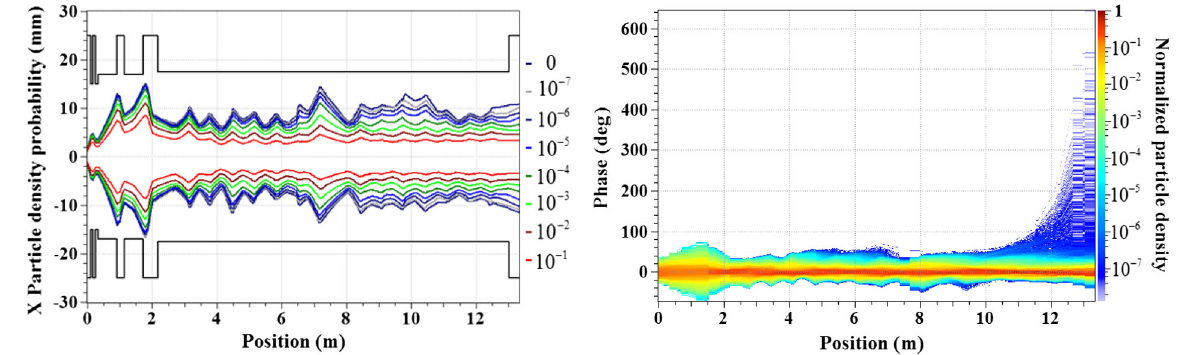
FIG. 25. The error analysis results of the 100% input emittance deviation case: transverse particle density level in the x plane (left) and longitudinal power density